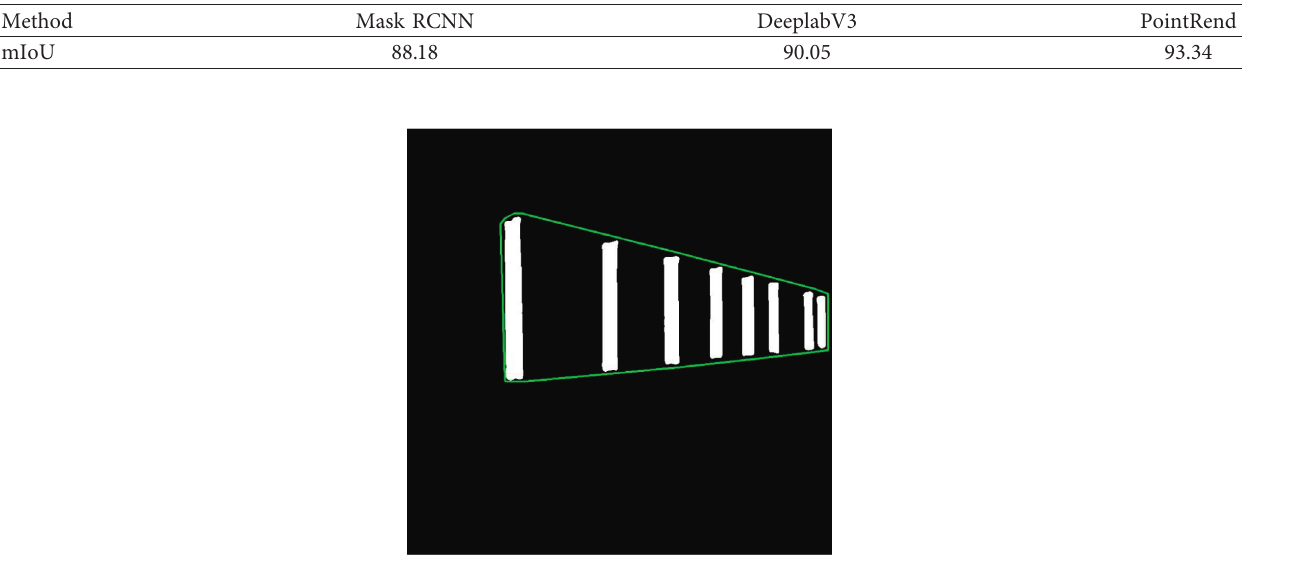
Figure 3: Segmentation comparison of (a) samples, (b) Mask RCNN [6], (c) DeepLabv33 [13], and (d) PointRend. Table 1: The mIoU on our collected dataset.